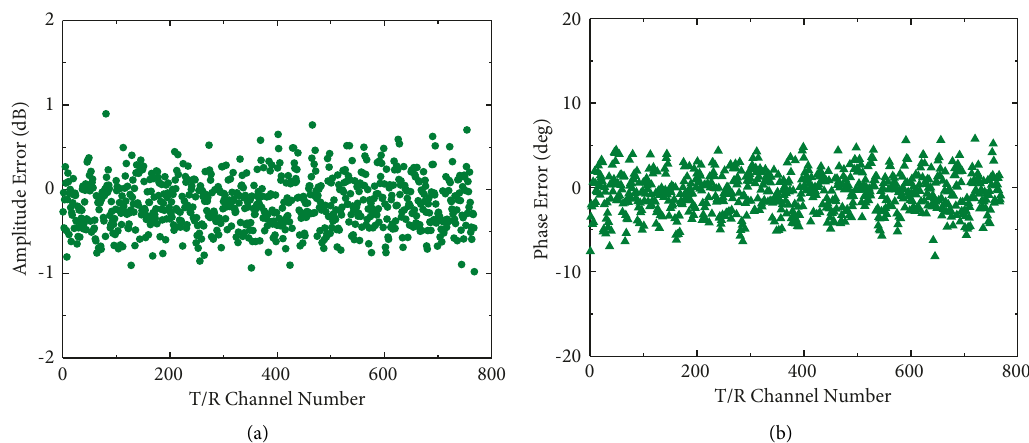
Figure 6: Internal calibration errors of 768T/R channels for S1 beam. (a) Amplitude errors, the RMS value is 0.3dB. (b) Phase errors, the RMS value is 2.3 °